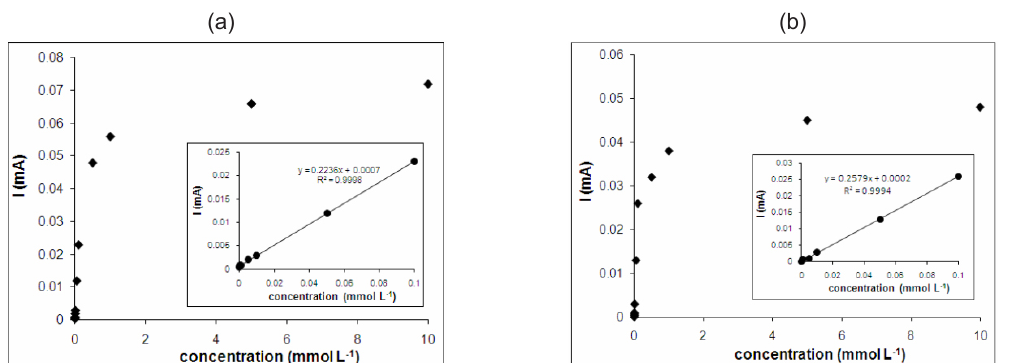
Figure 2. The relationship between the peak current and concentration of aminophylline determined by: (a) square-wave voltammetry (frequency 75 Hz; amplitude 50 mV; scan increment 5 mV; 20 o C); (b) differential pulse voltammetry (scan rate 0.04 V s -1 ; modulation amplitude 100 mV; modulation time 5 ms; 20 o C) in 0.2 mol L -1 acetate buffer pH 4.5 on electrochemically activated glassy carbon electrode (reference electrode Ag/AgCl; auxiliary electrode Pt wire). Inset: The linear relationships between the peak current and concentration of